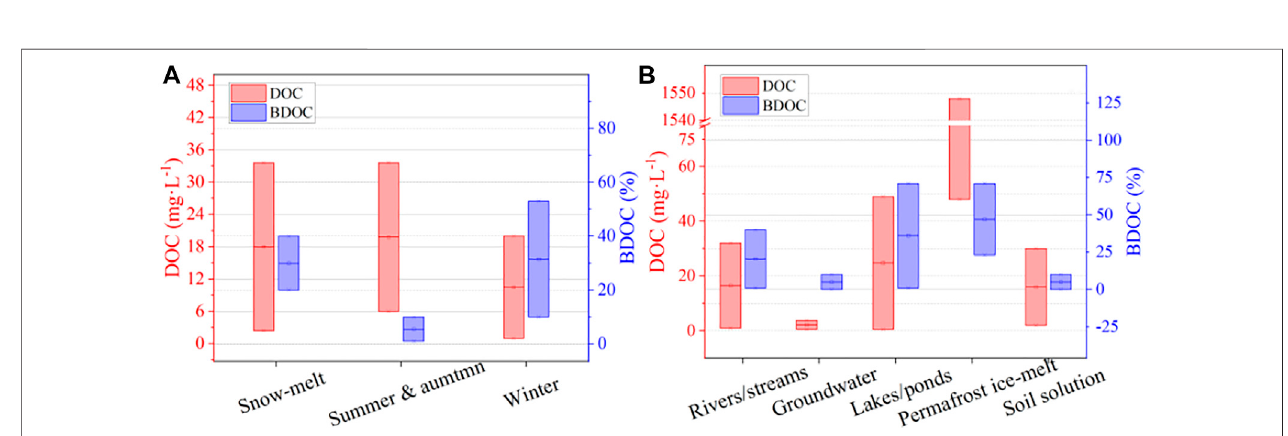
FIGURE 3 | Biplot of the PCA of various water types in the source area of the Yellow River (SAYR) and variable correlation plot (blue arrow).